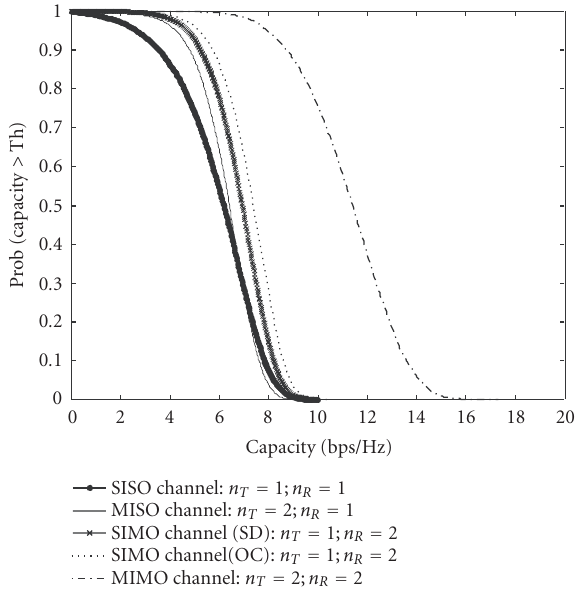
Figure 12: Theoretical capacity; SNR = 20dB.